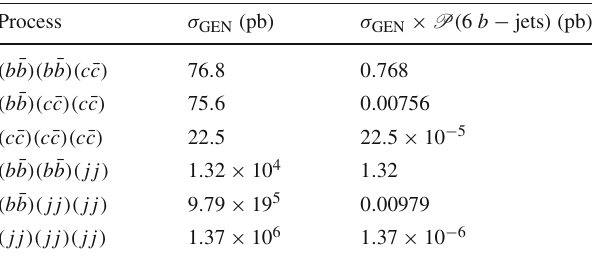
Table4 Thereduciblebackgroundprocessesconsideredinthesix b -jet analysis. The second column shows the generation-level cross sections with the cuts identical to the ones applied to the irreducible processes (Table2).Thethirdcolumnshowsthecrosssectionafterthemis-tagging rates have been applied. We only consider processes equivalent to QCD 6 b -jet production. We do not consider process that contain mis-tagged light and charm jets at the same